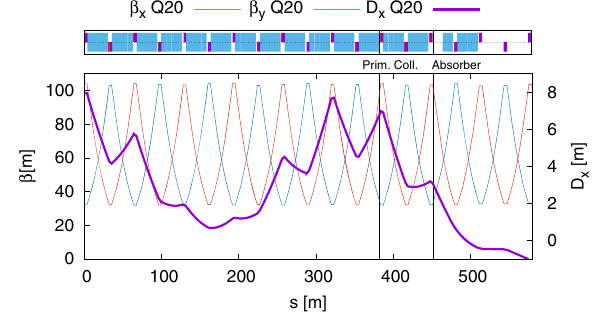
FIG. 3. Optics functions and location of collimators (black vertical lines).